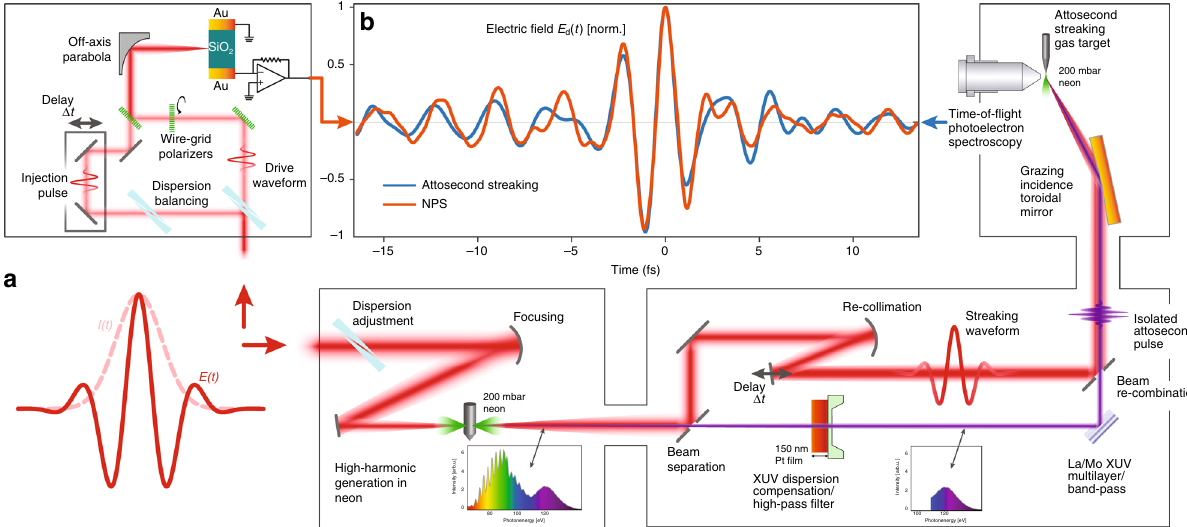
Fig. 2 Field metrology via attosecond streaking and nonlinear photoconductive sampling (NPS). The same few-cycle laser pulse ( a ) is sent to either the NPS setup or to an attosecond beamline. The NPS setup produces time-delayed replicas of the pulse with crossed polarizations, focused onto the quartz sample with adjustable time delay, while the signal induced at the end of their interaction with the solid in an external pair of electrodes is read electronically. In the attosecond beamline, attosecond streaking is used to obtain a comparative measurement of the temporal evolution of the laser fi eld, as it provides a broadband response in the relevant frequency range. In attosecond streaking, the laser pulse to be measured is coincident on a medium where bound electrons can be ejected by a synchronized attosecond pulse of extreme ultraviolet (XUV) light. The shift of the photoelectron energy vs. time delay allows the direct measurement of the vector potential of the laser pulse. The waveform obtained via the time-derivative of the energy shift of the photoelectrons emitted from a neon atom in an attosecond streaking experiment is also retrieved via NPS, returning the driving fi eld E d . The results are remarkably similar given the differences between the two measurement setups ( b